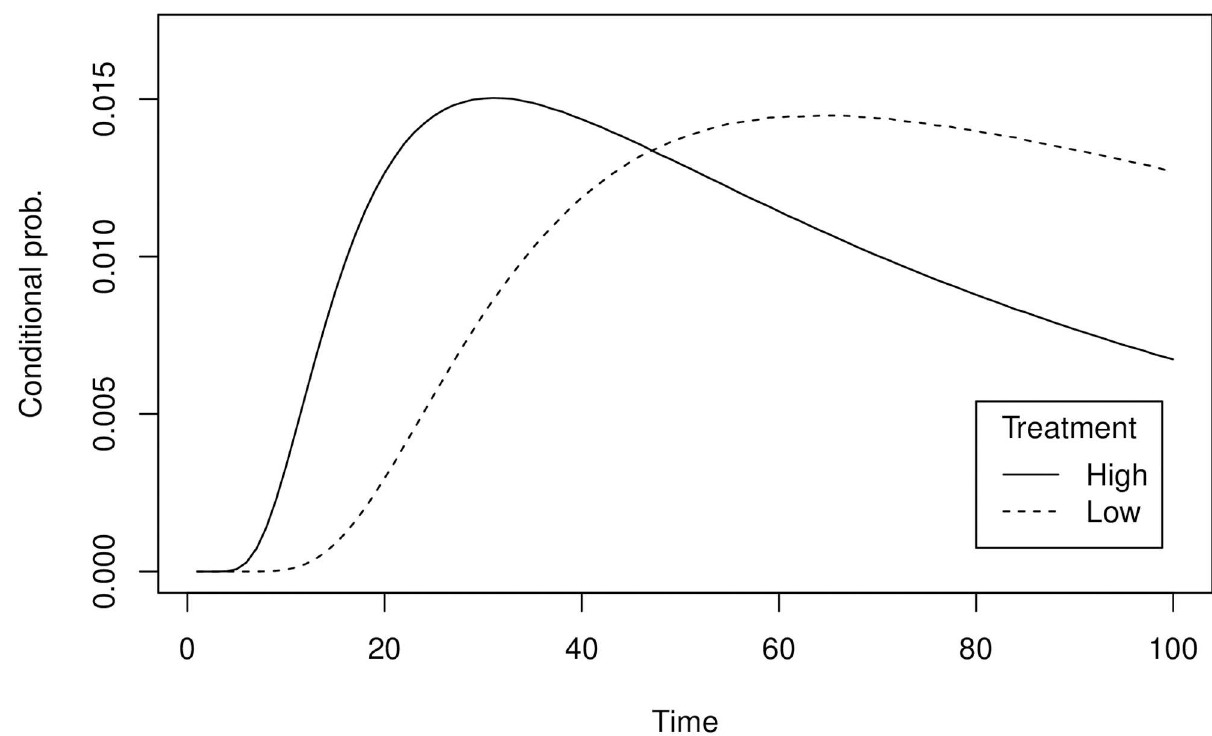
Fig 2. Distribution over termination times conditional on termination before t = 100. The dashedcurves relate to the low volatility treatment; the solid curve to the high volatility treatment.